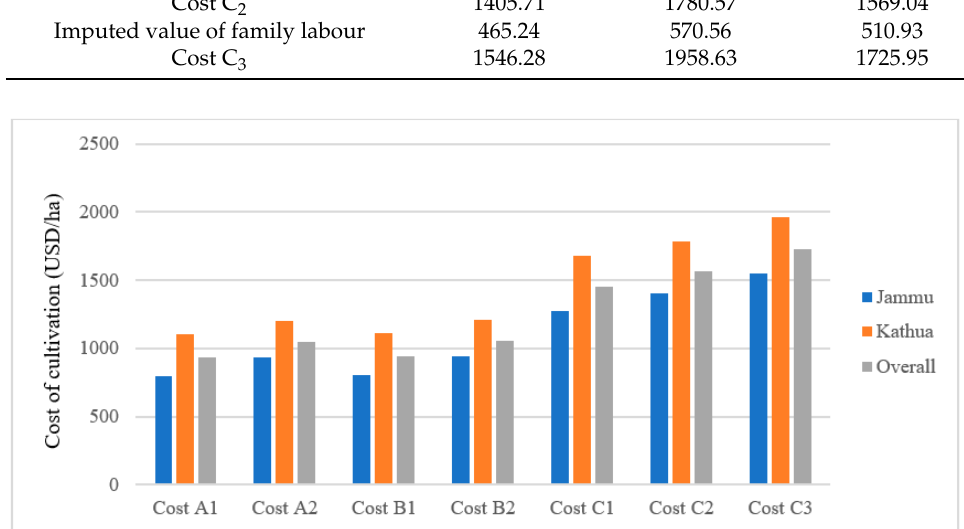
Figure 2. Cost structure of Marigold cultivation (USD ha − 1 ).